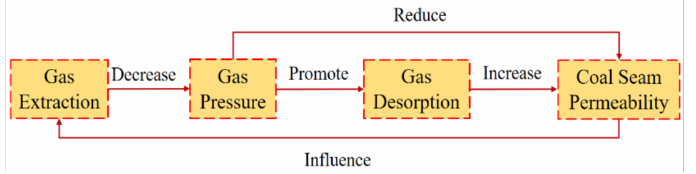
Figure 5. Relationship between gas drainage and